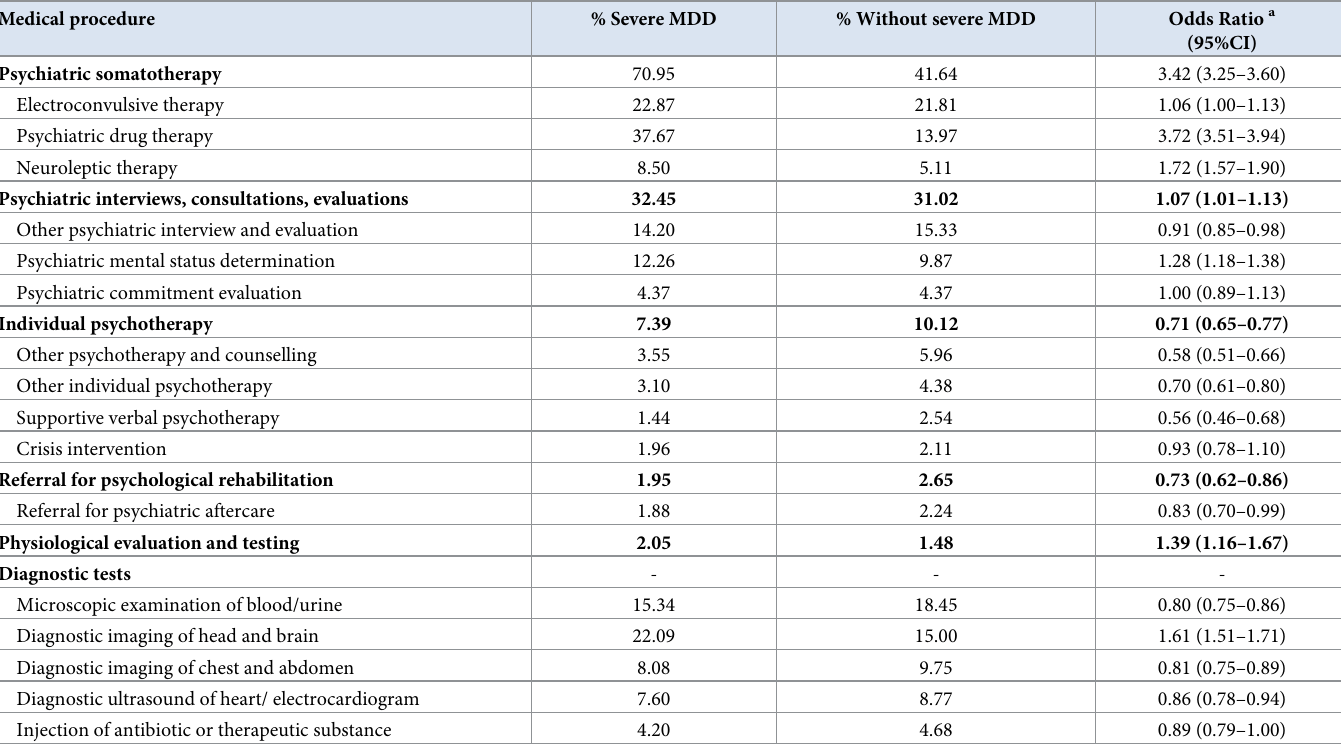
Table 3. Medical procedures found in more than 1% of admissions of all patients admitted with or without severe